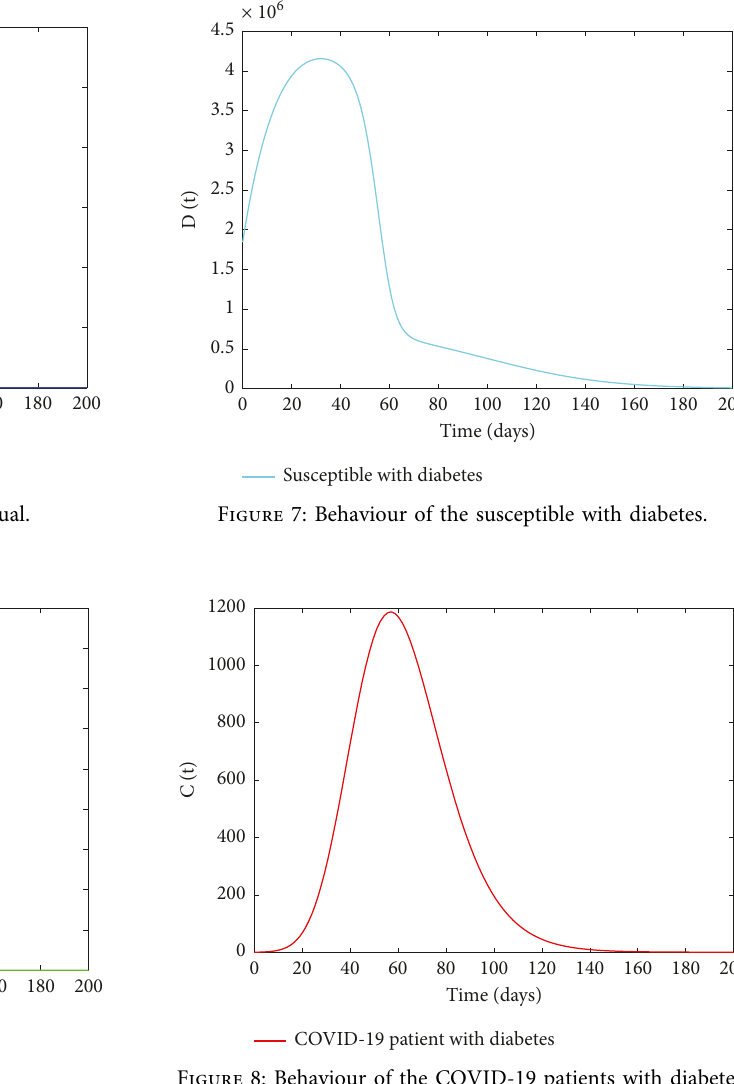
Figure 5: Behaviour of the individual exposed to COVID-19.